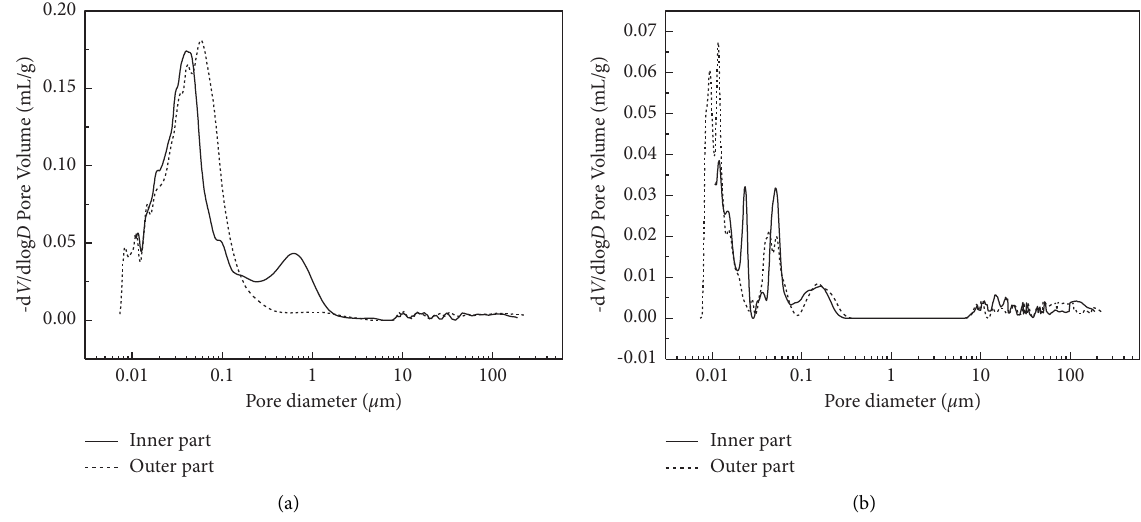
Figure 6: The pore size distribution curves of hardened cement paste: (a) 6 hours; (b) 120 days.